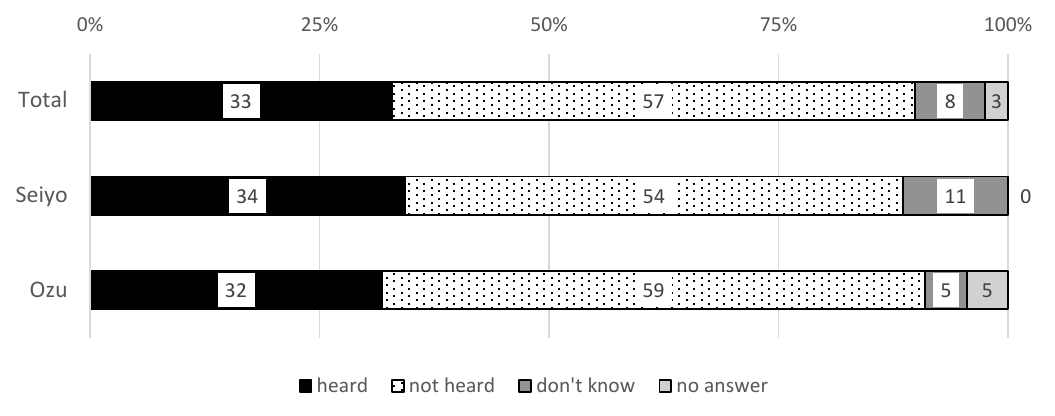
Figure 8. Rate at which the discharge warning was heard (%), n = 79.